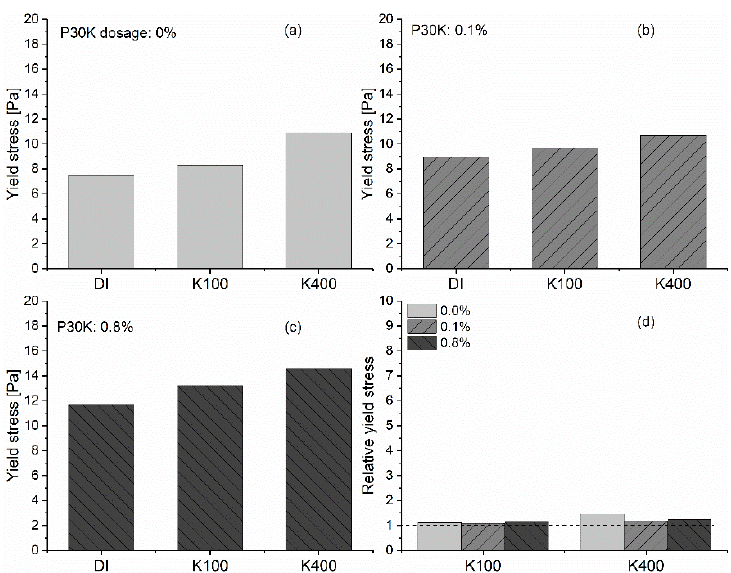
Figure 5. E ff ect of [K + ] on the yield stress of GBS with di ff erent dosages of P30K; ( a ) 0 %; ( b ) 0.1 %; Figure 5. Effect of [K + ] on the yield stress of GBS with different dosages of P30K; ( a ) 0 % ; ( b ) 0.1 % ; ( c ) ( c ) 0.8 %; ( d ) relative yield stress along with increasing [K + 0.8 % ; ( d ) relative yield stress along with increasing [K + ].